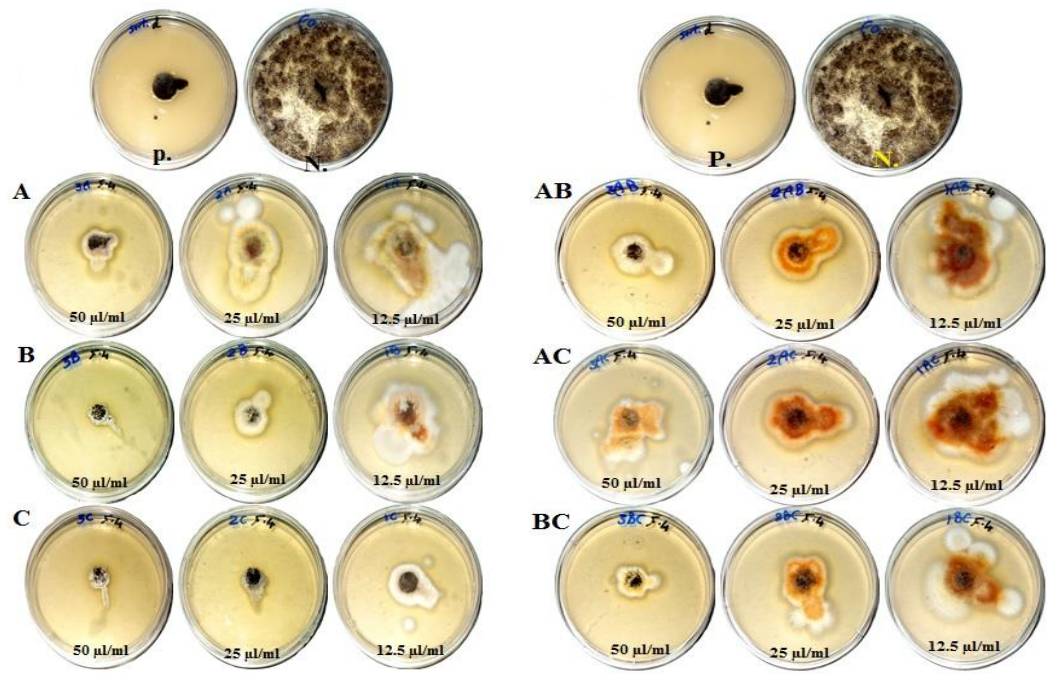
Processes 2018 , 6 , x FOR PEER REVIEW 8 of 17 Figure 3. Visual observation of A. niger growth inhibition as a ff ected by the EOs from ( A ) C. aurantium oil, (Sertaconazol 3 g/L). ( N ) Negative control (DMSO 10%). ( AB ) C. aurantium oil + E. camaldulensis oil. ( B ) E. camaldulensis oil, and ( C ) C. sinensis oil and their combinations. ( P ) Positive control (Sertaconazol 3 Figure 3. Visual observation of A. niger growth inhibition as affected by the EOs from ( A ) C. aurantium ( AC ) C. aurantium oil + C. sinensis oil. ( BC ) E. camaldulensis oil + C. sinensis oil. g / L). ( N ) Negative control (DMSO 10%). ( A , B ) C. aurantium oil + E. camaldulensis oil. ( A , C ) C. aurantium oil, ( B ) E. camaldulensis oil, and ( C ) C. sinensis oil and their combinations . ( P ) Positive control oil + C. sinensis oil. ( B , C ) E. camaldulensis oil + C. sinensis oil.